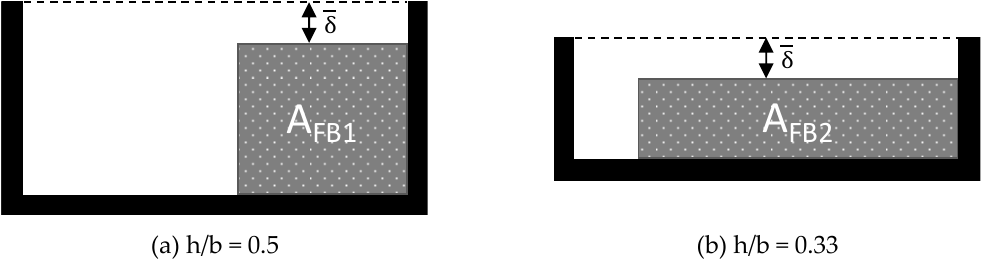
Figure 14. Comparison of the solid bed geometries with constant solids contents but variable channel depths.